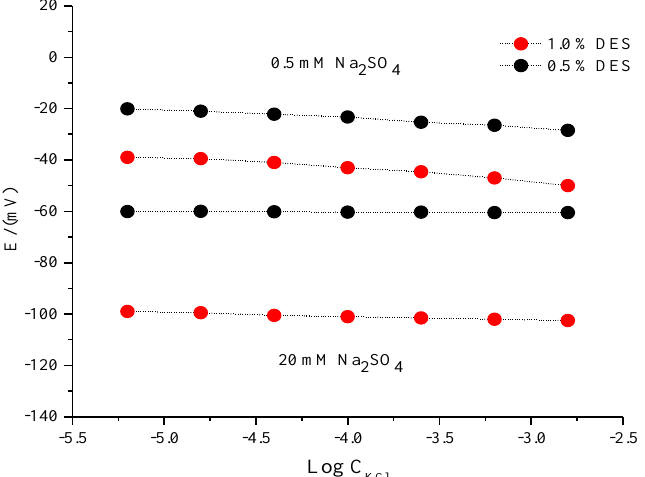
Figure 5. Potential dependency profile of the fabricated Ag/AgCl reference electrode containing 0.5 and 1.0% IL under various concentrations of KCl in diluted Na 2 SO 4 (0.5 mM) and concentrated Na 2 SO 4 (20 mM).